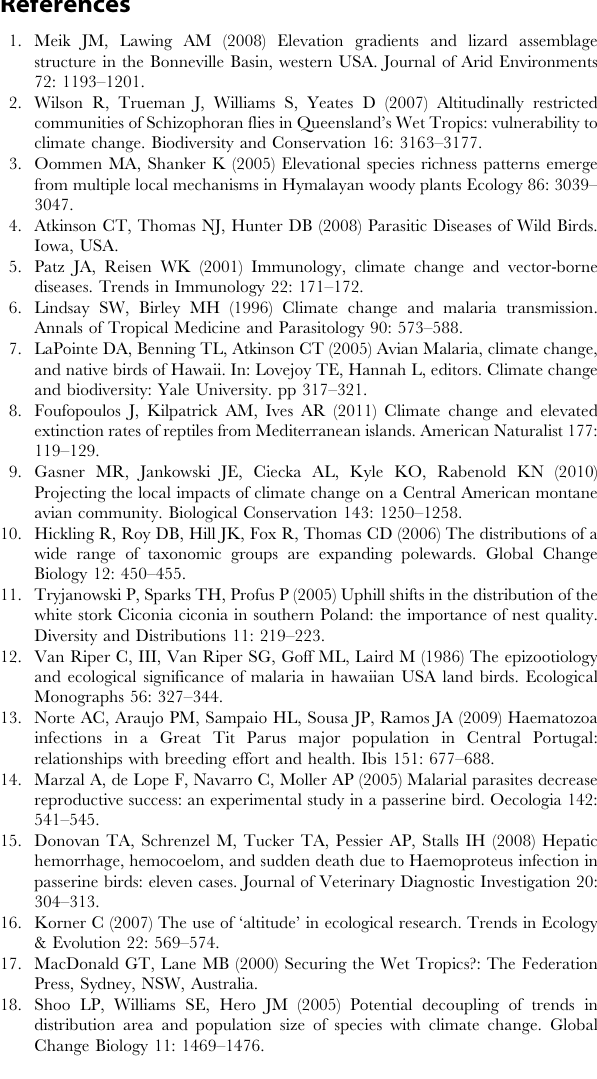
Table S1 The full list of frequency of detection of blood parasites. Haemoproteus ( Hae ), Plasmodium ( Pla ), Leucocytozoon ( Leu ) and Trypanosoma ( Try ) in all the avian species presented alphabetically by family. Number of infected individuals/number of individuals sampled are shown. Table S2 Primer sequences used for the two PCR step reactions to detect blood parasites. Primers used to amplify Cytochrome b (Cyt-b) in Plasmodium (Pla), Haemoproteus (Hae) and Leucocytozoon (Leu), and 18 S rRNA (18 S) in Trypanosoma (Try). Table S3 The full list of parasite lineages and host